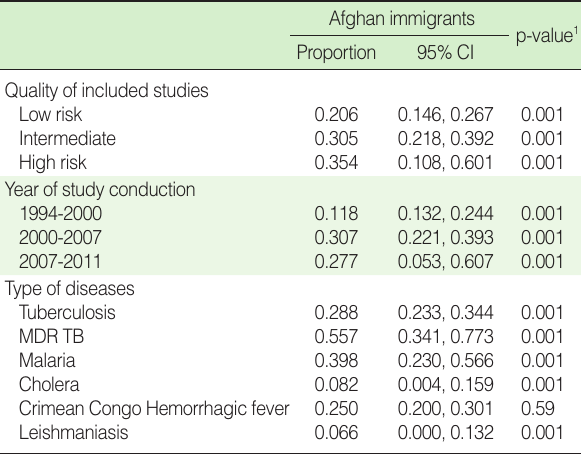
CI, confidence interval; MDR TB, multiple-drug-resistant tuberculosis. 1 p-value for chi square test for